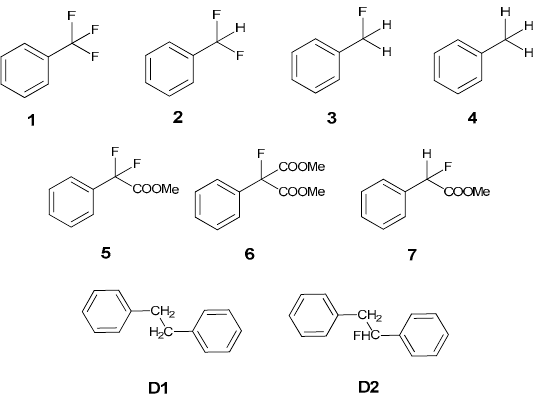
Figure 1. Chart of structures. Compound 1 is the reactant, whereas compounds 2-7 and D1-D2 are products obtained after controlled potential electrolysis under nitrogen or carbon dioxide atmos- phere.